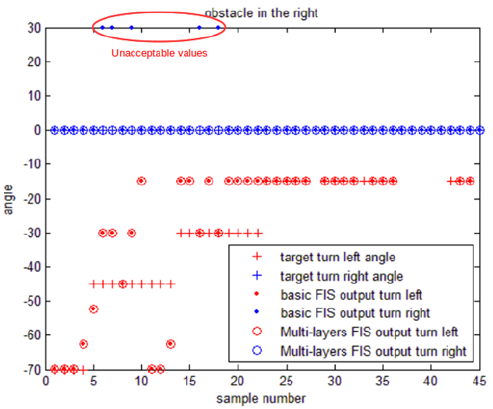
Fig. 14. Outputs of the multi-layer FIS and one-layer FIS and target angles when the obstacle is at the